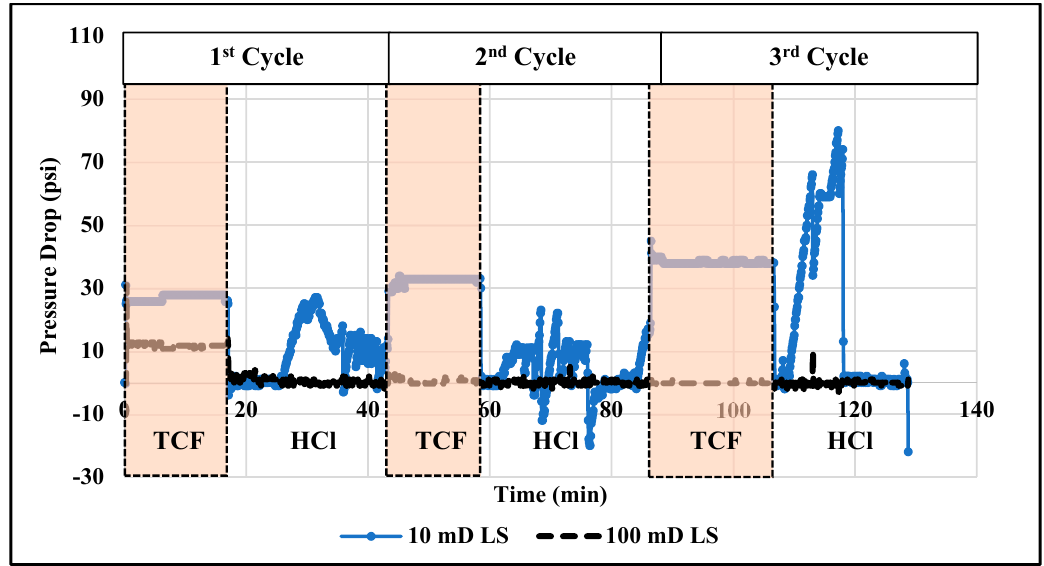
Figure 8. Profiles of inlet (Pin) and outlet (Pout) pressures and the pressure-drop across the high- permeability sample during the thermochemical/HCl treatment.